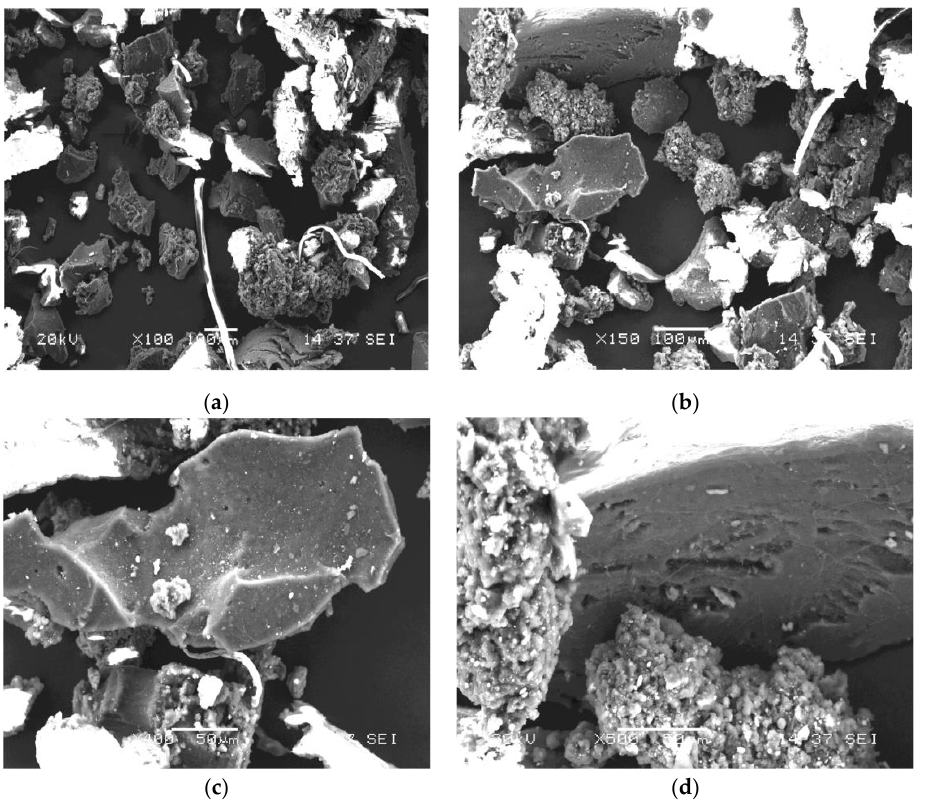
Figure 1. SEM analysis of CR: ( a ) ×100; ( b ) ×150; ( c ) ×400; ( d ) ×600.